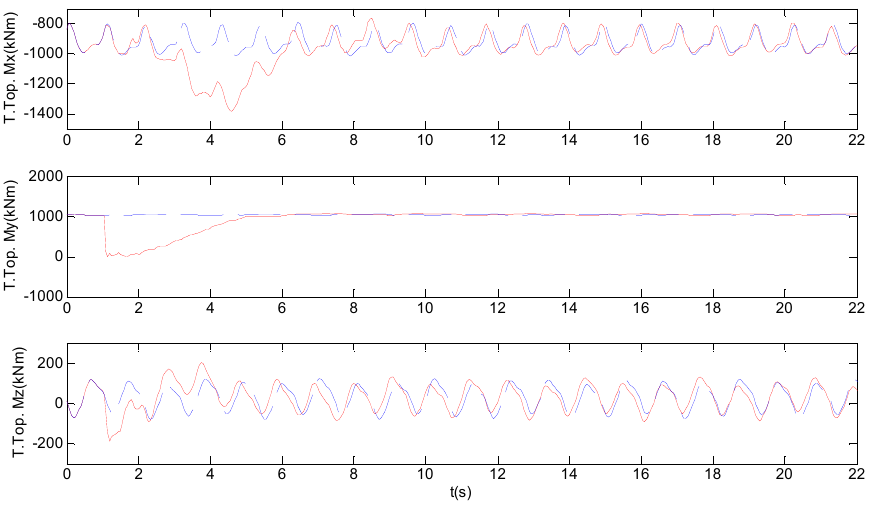
Figure 16. Blade root bending